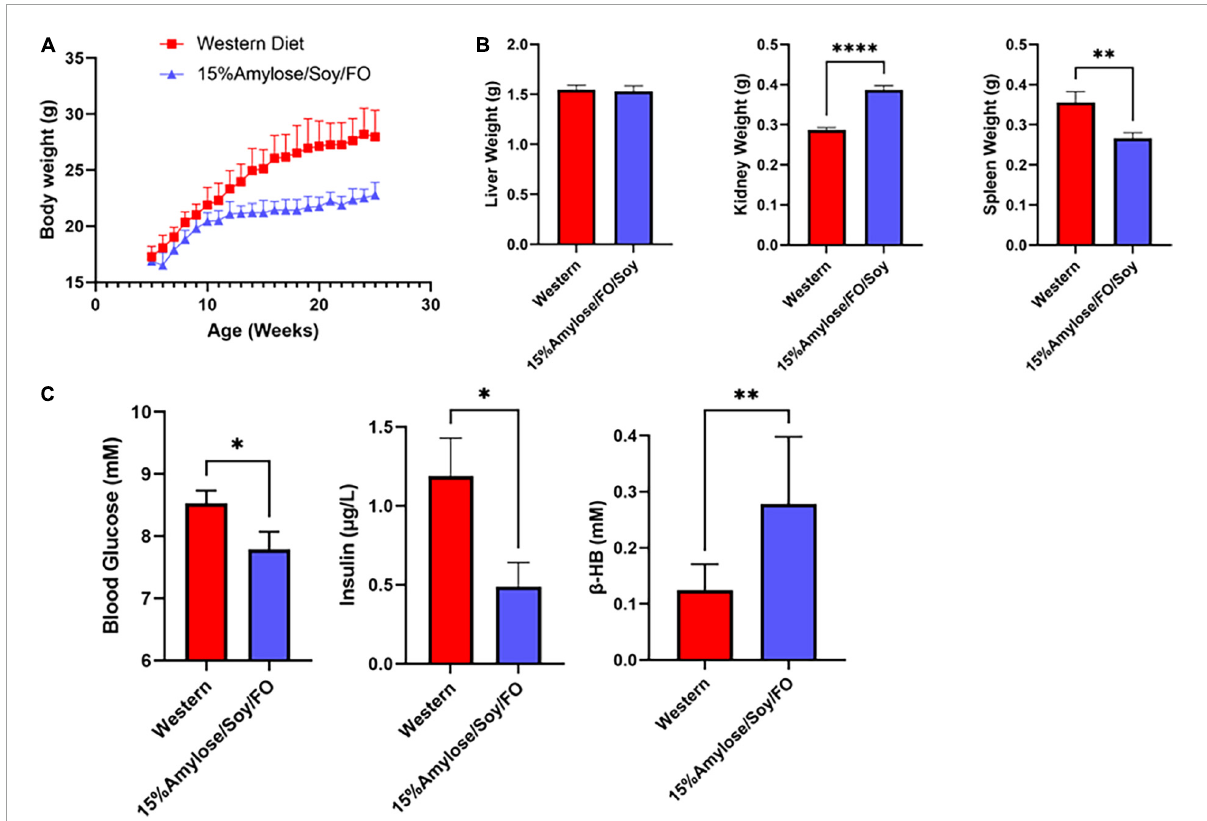
FIGURE4 A 15%Amylose/Soy/FO diet reduces body weight, spleen enlargement, blood glucose, and insulin levels and increases β -hydroxybutyrate in 6-month-old miR-146a KO mice. (A) At 5 weeks of age, miR-146a KO mice were housed in two-tiered rat cages with exercise wheels and put on a Western (10 mice) or the 15%Amylose/Soy/FO diet (10 mice) and their weights monitored weekly. (B) Liver, kidneys and spleens were weighed following euthanasia of the miR-146a KO mice on the two diets at 6 months of age. (C) Blood glucose, insulin, and β -HB levels were monitored 1 week prior to euthanasia. The data are shown as the mean +/– SEM. ∗ P < 0.05, ∗∗ P < 0.01, ∗∗∗∗ P <